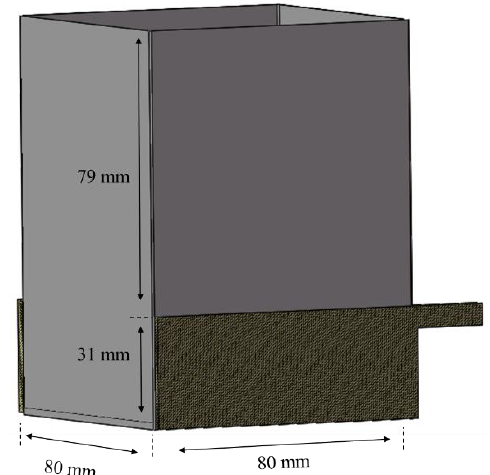
Figure 6. The structure and size of the designed sensor.